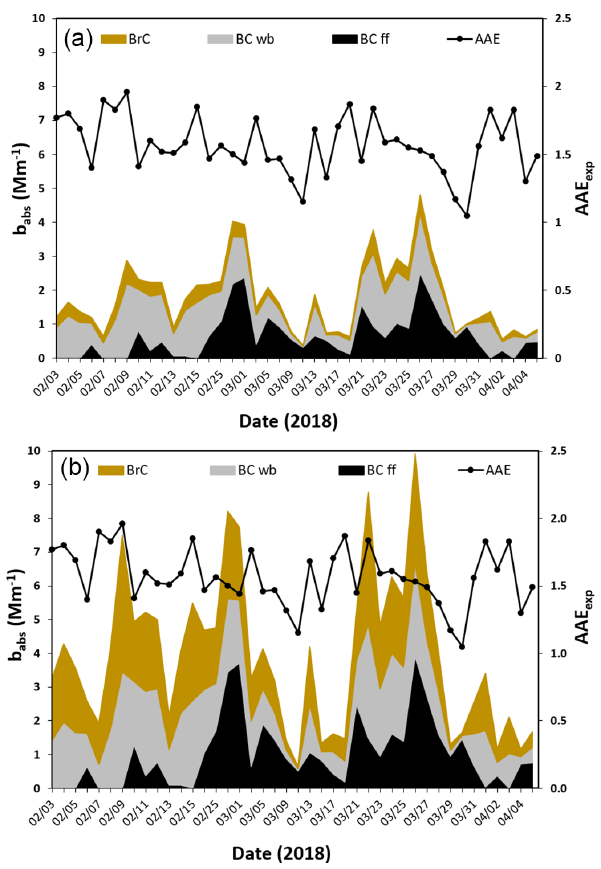
Figure 5. Primary axis: optical apportionment of the aerosol ab- sorption coefficient ( b abs ) at λ = 635 (a) and λ = 405nm (b) . Sec- ondary axis: experimental AAE (AAE exp ) values obtained by fit- ting the measured b abs values with a power-law relationship b abs ( λ ) ∼ λ − AAE . FF and WB stand for fossil fuel and wood burning, respectively.